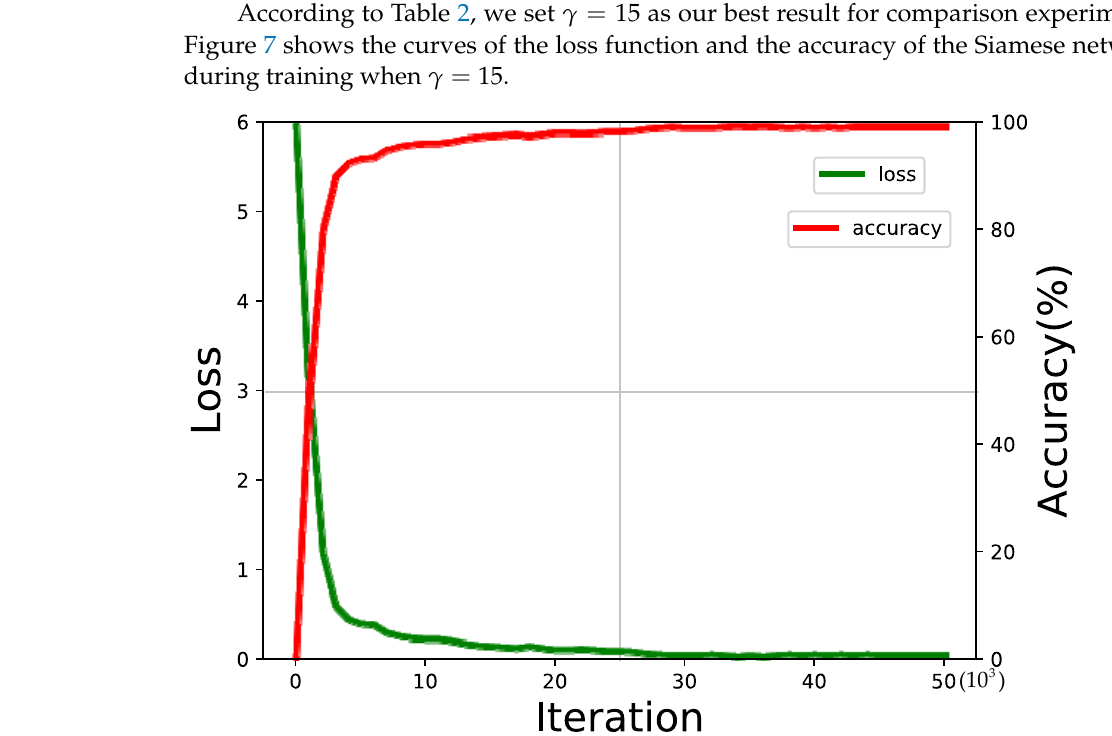
Figure 6. ( a – c ) represent the Curves of prediction accuracies with different metrics θ for Roll, Pitch, Yaw respectively.